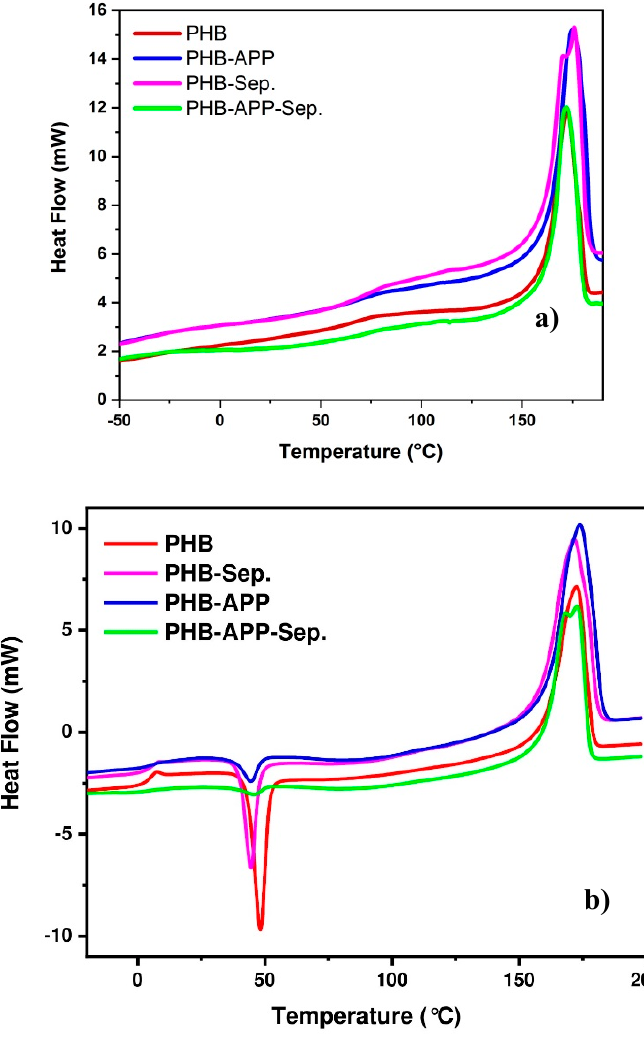
Figure 4. DSC curves for PHB, PHB-Sep., PHB-APP, PHB-APP-Sep. samples, ( a ) 1st heating ( b ) 2nd heating. Table 4. DSC curves data of PHB and all composites (The values of enthalpy of melting for blends are normalized in compositions).